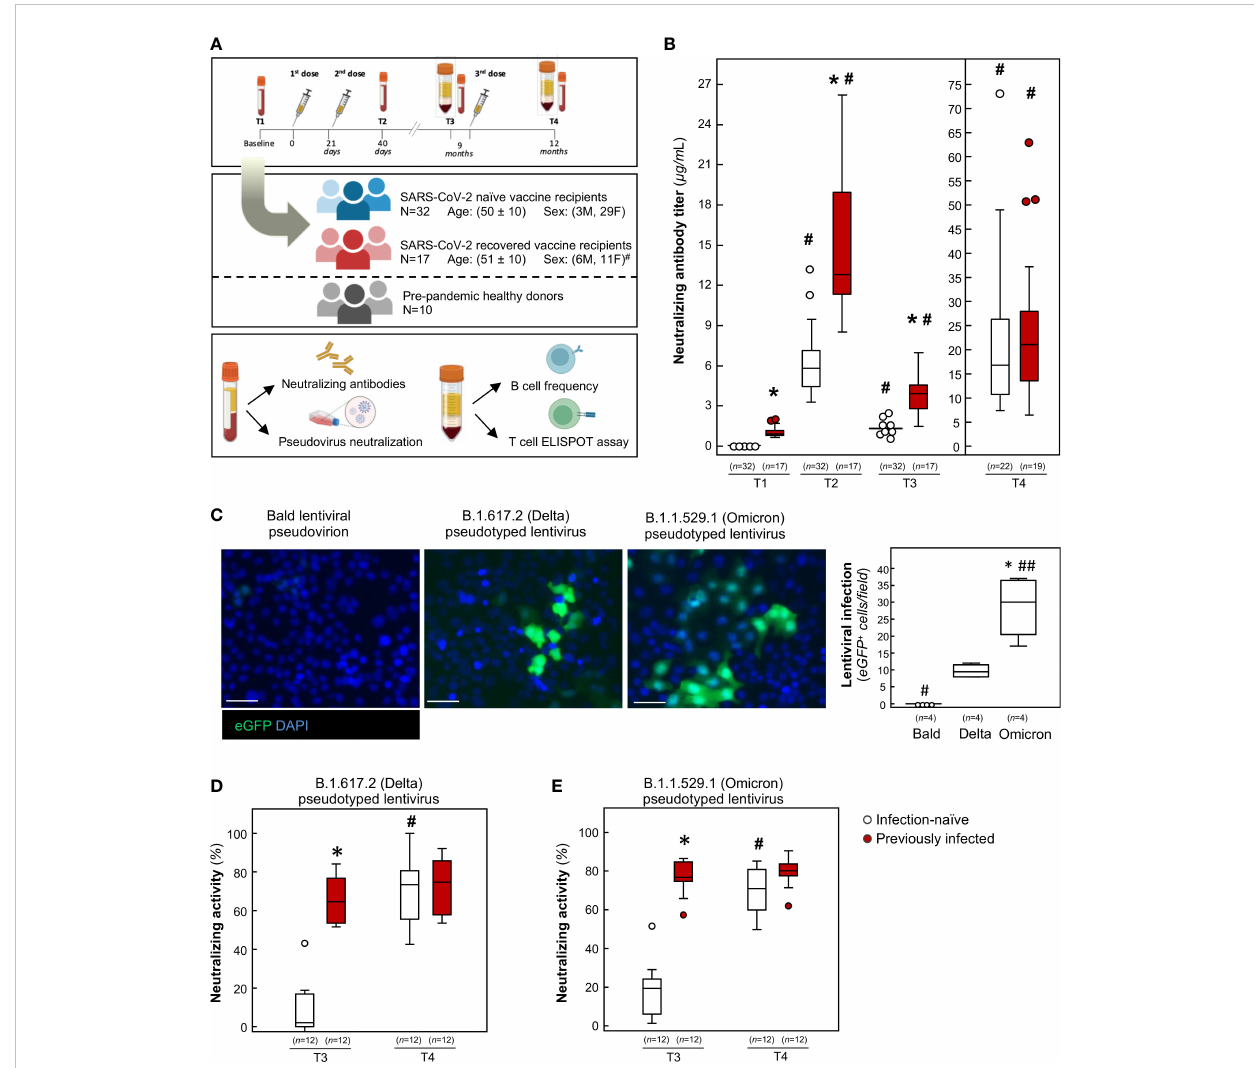
FIGURE 1 Humoral response and neutralizing activity of infection-naïve and previously infected vaccine recipients over time. (A) Schematic representation depicting the study design. Drawings were created using BioRender. # p-value =0.049 vs infection-naïve subjects. (B) Evaluation of neutralizing anti- RBD IgG in infection-naïve and previously infected vaccine recipients at baseline (T1), 19 days after primary vaccination (T2), 9 months after primary vaccination (T3), and 3 months after the booster dose (T4). * p-value <0.0001 vs infection-naïve subjects; # p-value <0.0001 vs the respective T1. (C) Representative images and quanti fi cation of lentiviral construct infection in Vero E6 cells overexpressing human angiotensin converting enzyme 2 (ACE2). Nuclei are counterstained with Hoechst. Scale bar: 50 m m. * p-value <0.001 vs Bald, # p-value <0.01; ## p-value <0.001 vs Delta. (D, E) Quanti fi cation of neutralizing activity of sera against (D) B.1.617.2 (Delta) and (E) B.1.1.529.1 (Omicron) at T3 and T4. * p-value <0.0001 vs infection-naïve subjects; # p-value <0.0001 vs the respective T3. The sample size ( n ) for each panel is indicated in